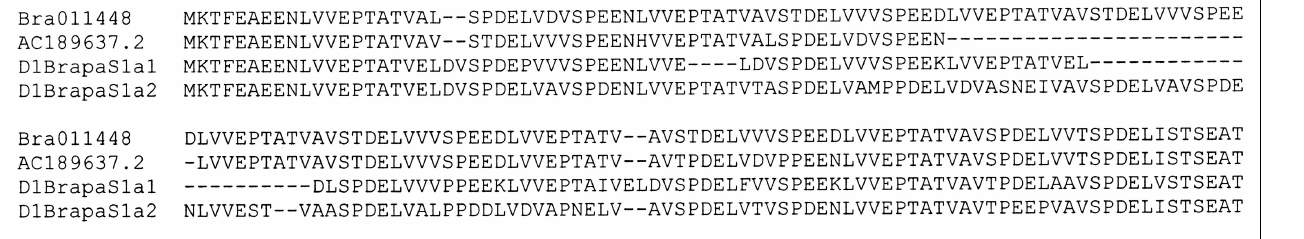
FIGURE 4 | Four different alleles of D1BrapaS1 show four different combinations of in-frame deletions in Bra011448. The sequence shown is the portion of Bra011448 that is predicted to encode an rne domain and lies